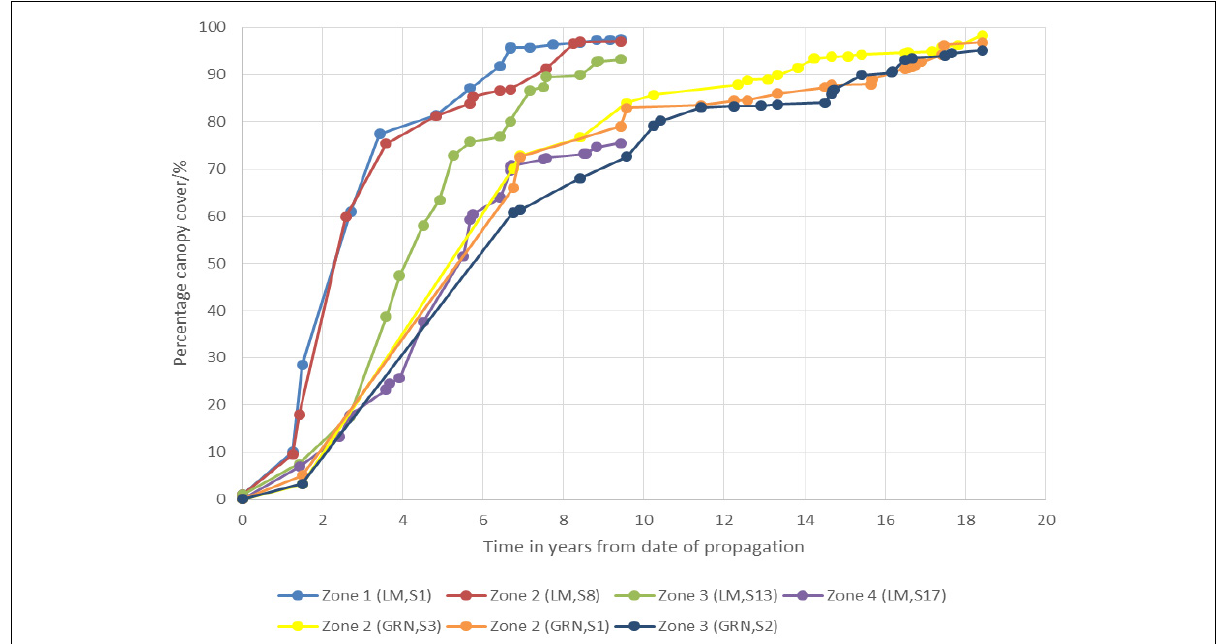
Figure 4: Typical percentage canopy cover pattern observed at Le Morne (LM): Zone 1 (LM S1) in blue, Zone 2 (LM S8) in red, Zone 3 (LM S13) in green and Zone 4 (LM S17) in purple, and at Grande Rivière Noire (GRN): Zone 2 (GRN S3) in yellow, Zone 2 (GRN S1) in orange and Zone 3 (GRN S2) in dark blue. The x -axis represents the time in years from the date of propagation; GRN 2003 and LM